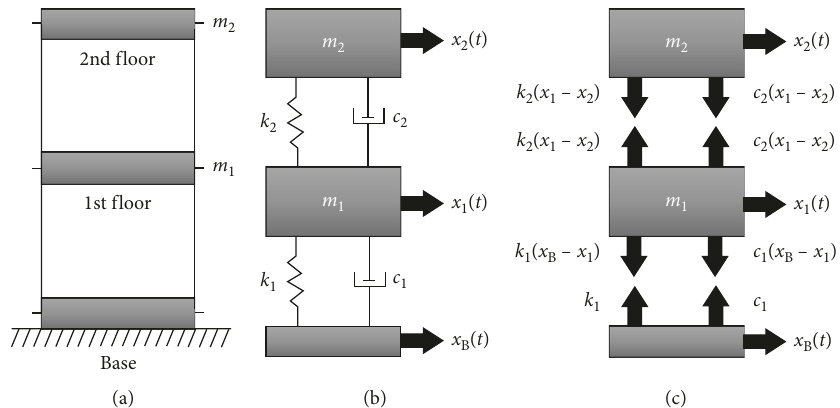
Figure 2: Representation of a 2DOF system with base excitation. (a) A simple model that simulates a two-floor building, (b) diagram of concentrated masses, and (c) free-body diagram of the